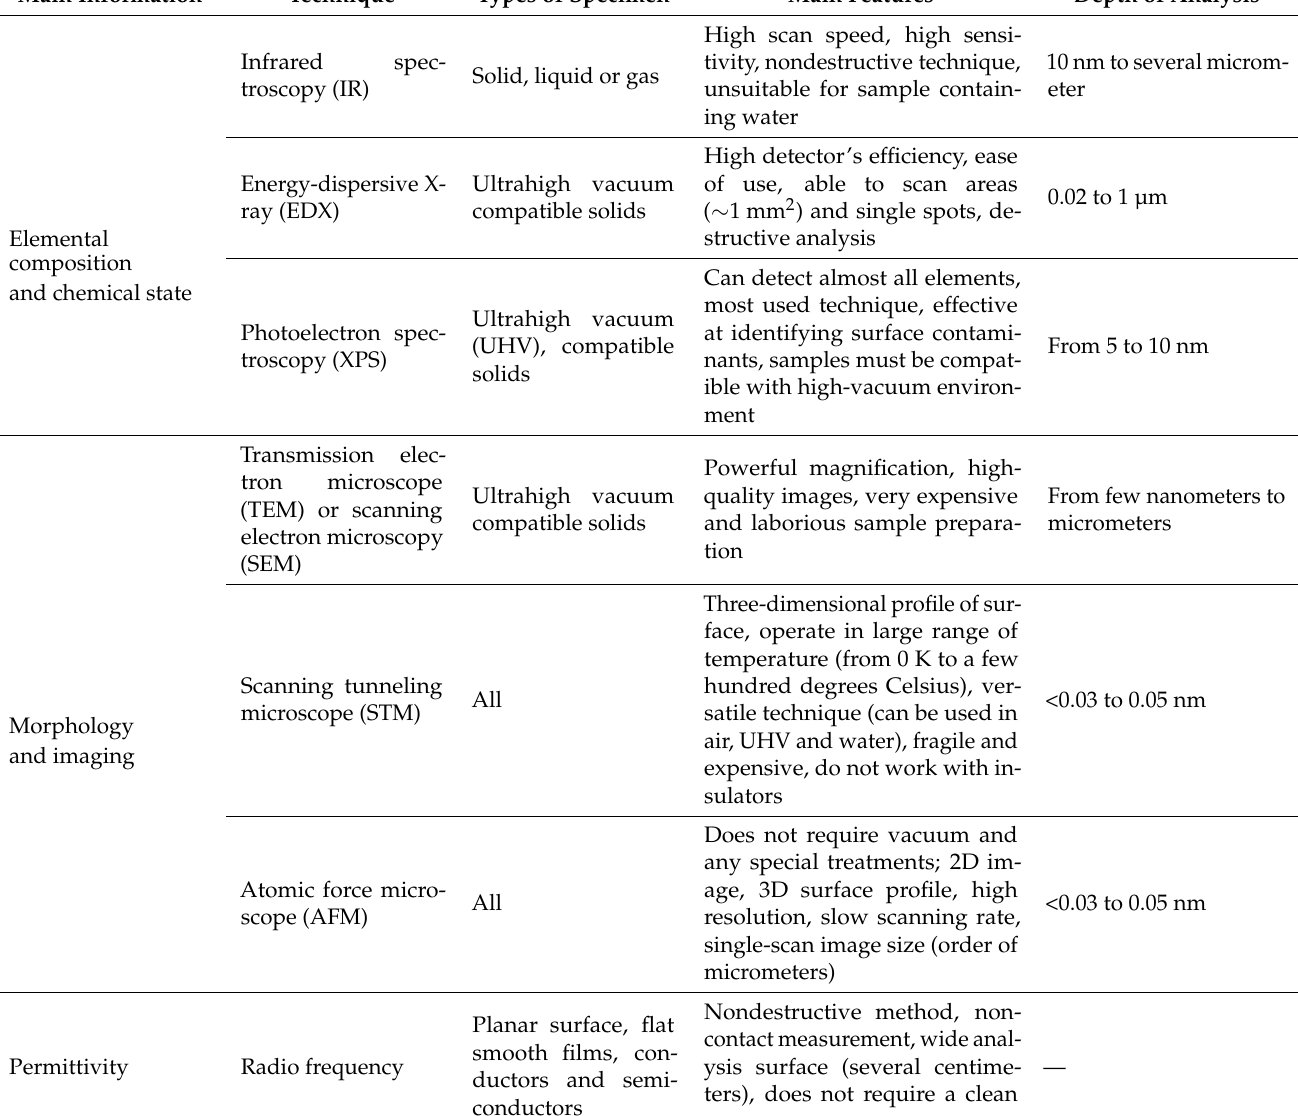
Table 1. Different methods for surface